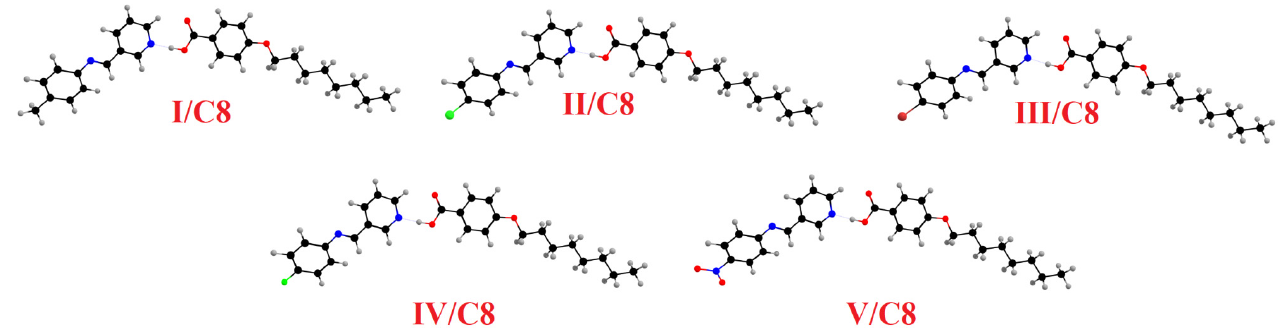
Figure 4. The calculated molecular geometry of the prepared supramolecular para-octyloxy benzoic acid complexes (( I-V ) C8 ), H (gray), C (black), N (blue) and O (red). 2.3. Frontier Molecular Orbitals (FMO) and Polarizability.